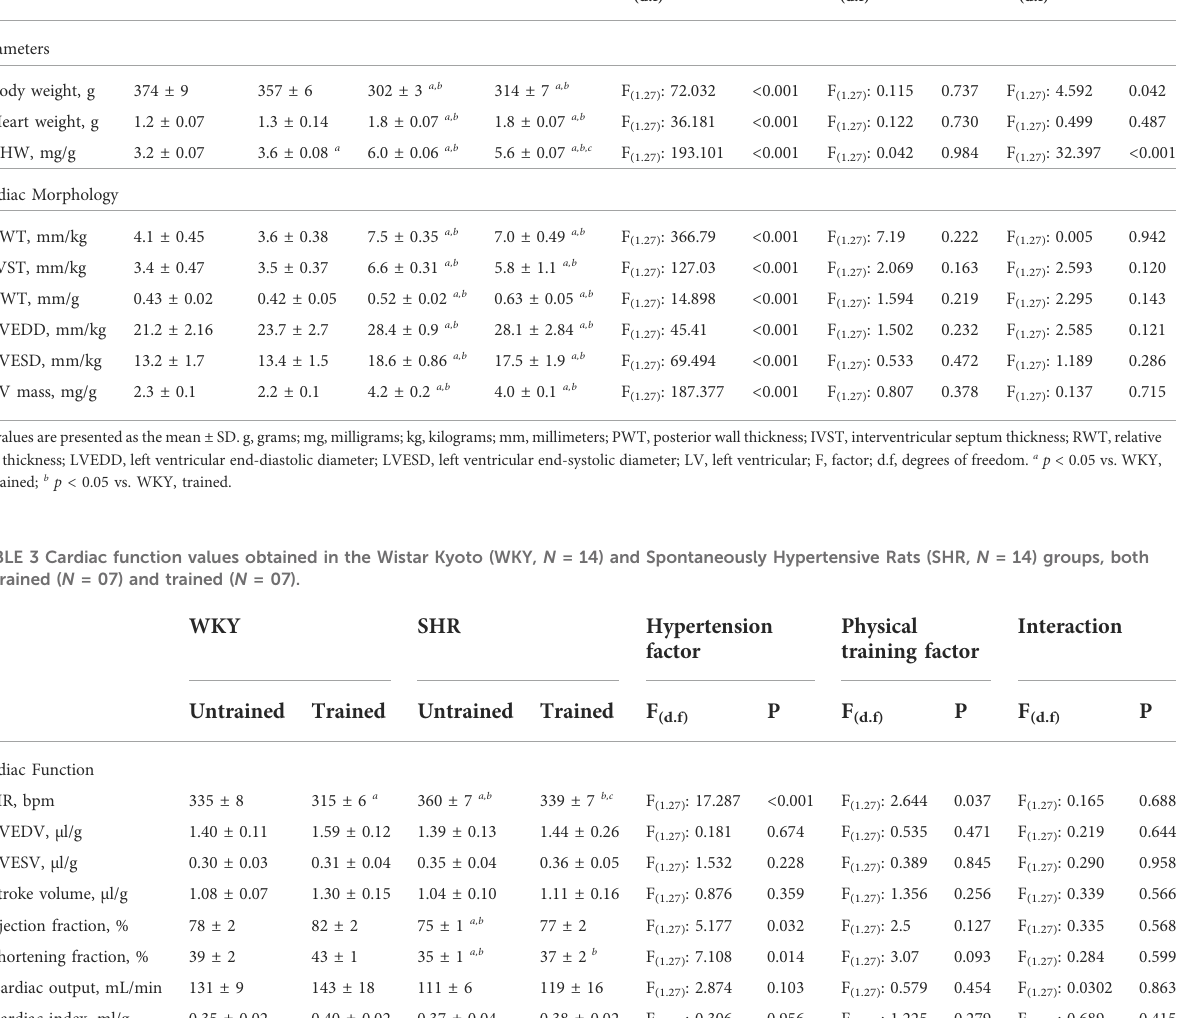
TABLE 2 General characteristics and cardiac morphology parameters for the Wistar Kyoto (WKY, N = 14) and spontaneously hypertensive rats (SHR, N = 14) groups, both untrained ( N = 07) and trained ( N = 07). WKY SHR Hypertension Untrained Trained Untrained Trained F (d.f) P F (d.f) P F (d.f) P